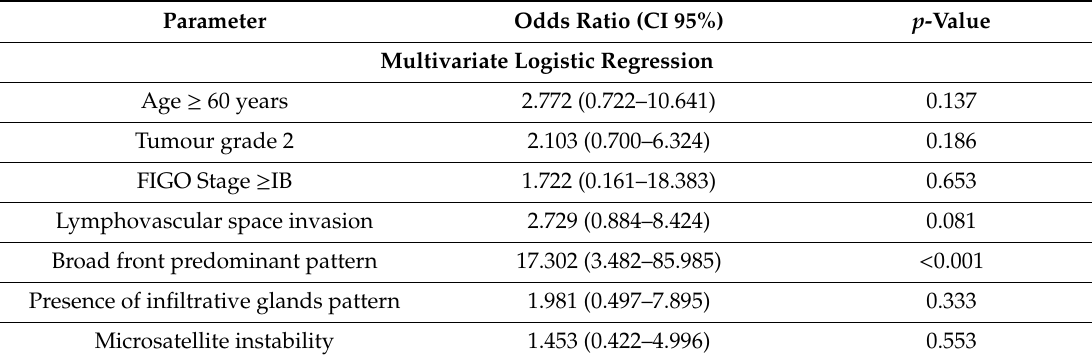
Table 4. Multivariate analyses of odds ratios in the logistic regression model with relapse as the dependent